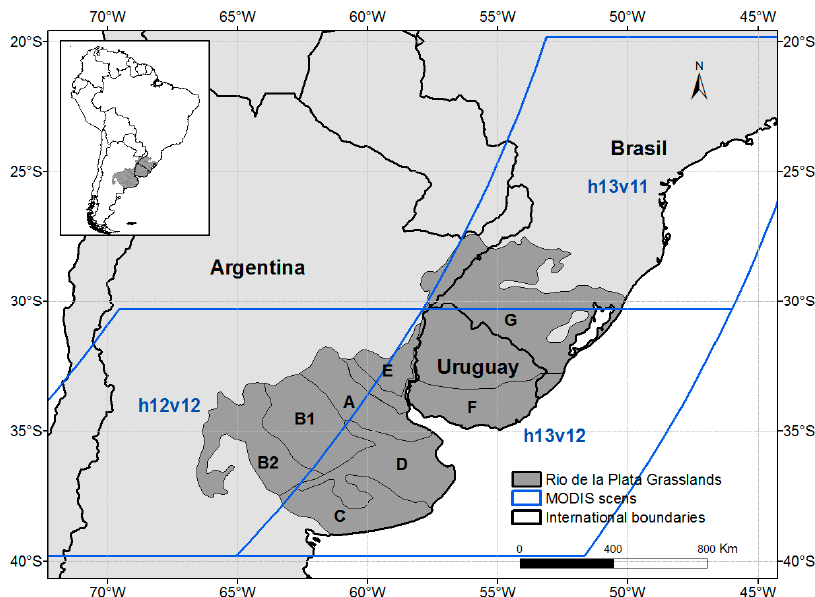
Figure 1. Geographical location of Rio de la Plata Grasslands (RPG) and its different sub regions: ( A ) Rolling Pampa; ( B1 ) Flat Inland Pampa; ( B2 ) West Inland Pampa; ( C ) Southern Pampa; ( D ) Flooding Pampa; ( E ) Mesopotamic Pampa; ( F ) Southern Campos; ( G ) Northern Campos. In blue the three MODIS tiles used in land use/land cover classifications.